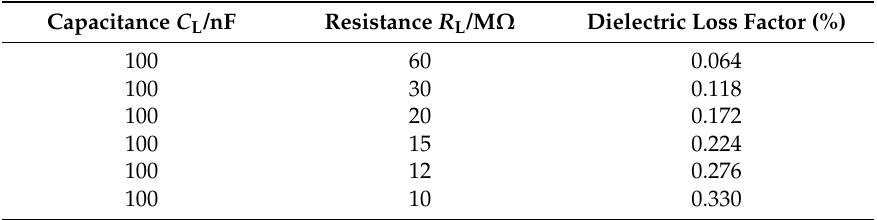
Table 3. Dielectric loss factor of low-voltage capacitor with different resistance.